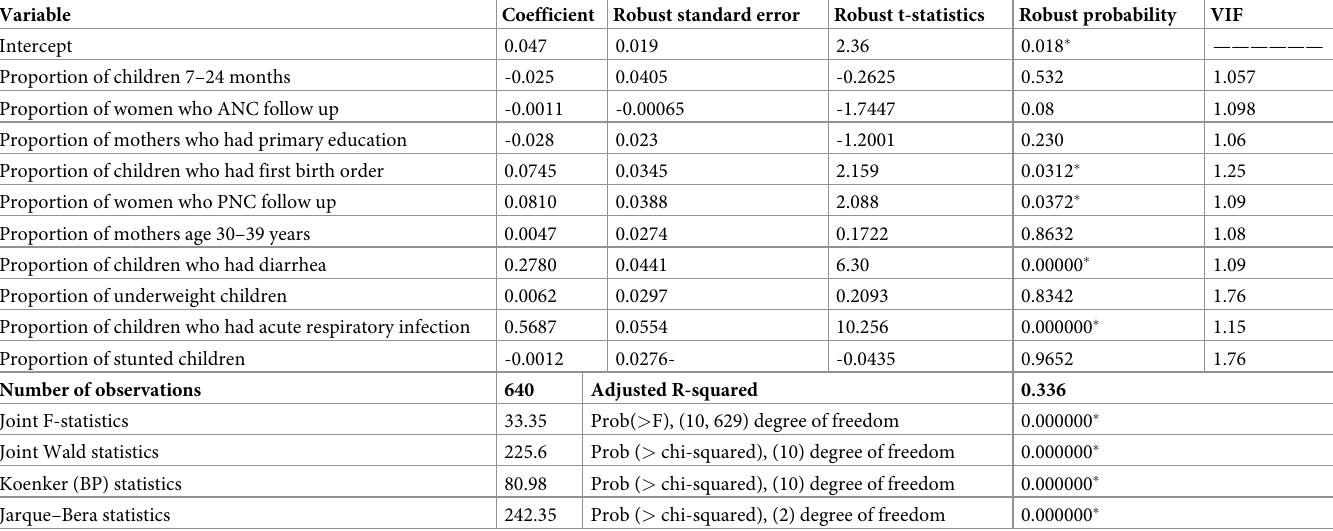
Table 4. The ordinary least square regression analysis result for childhood febrile illness Ethiopia 2016.